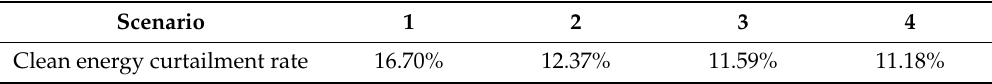
Figure 3. Unit output and wind/photovoltaic curtailment in different scenarios. ( a ) Unit output and wind/photovoltaic curtailment in S1. ( b ) Unit output and wind/photovoltaic curtailment in S2. ( c ) Unit output and wind/photovoltaic curtailment in S3. ( d ) Unit output and wind/photovoltaic curtailment in S4. Table 7. Clean energy curtailment rates in different scenarios